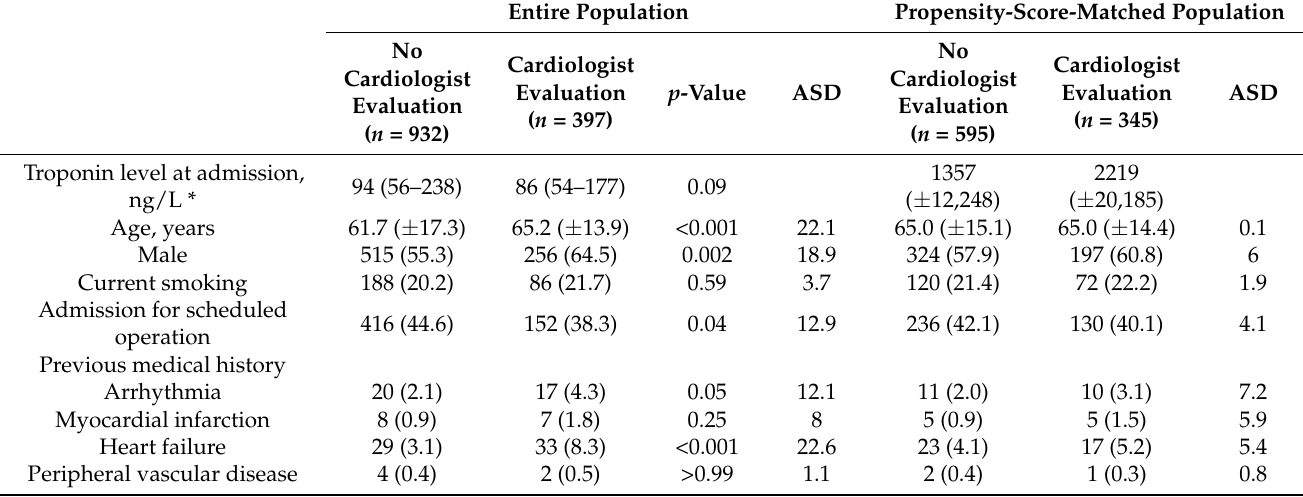
Table 1. Baseline characteristics of the study